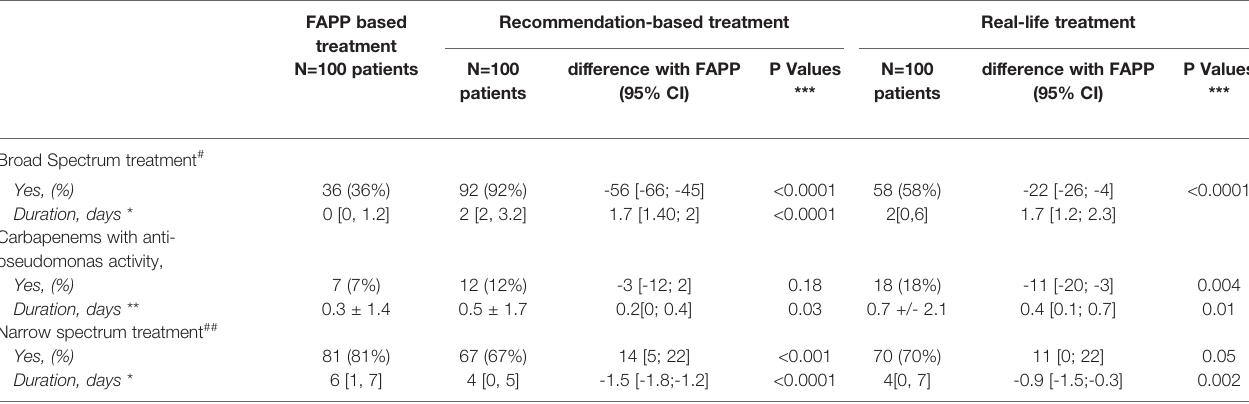
FAPP based Recommendation-based treatment Real-life treatment treatment